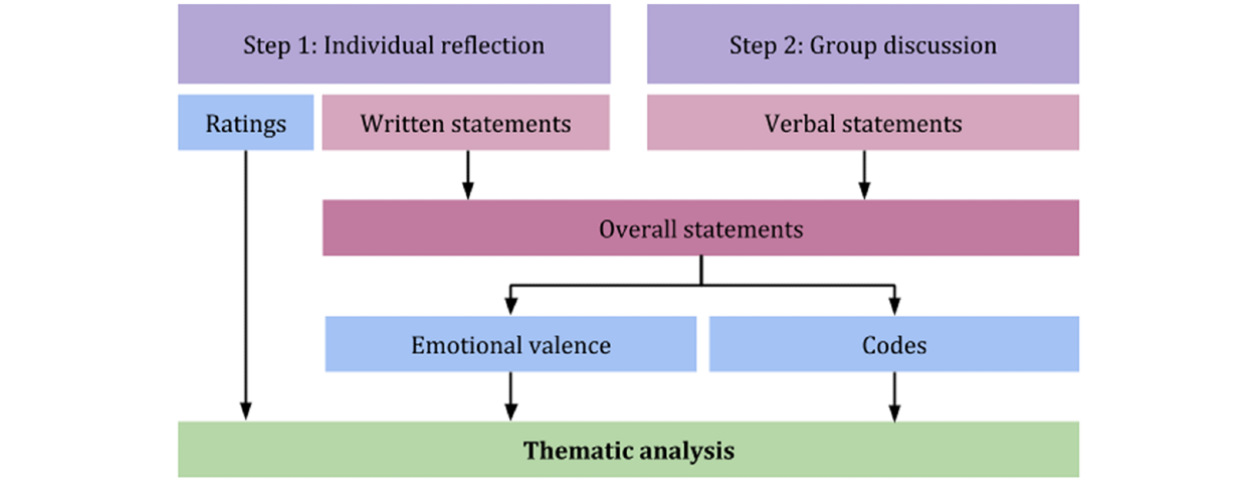
Figure 1. Overview of the 2-step research